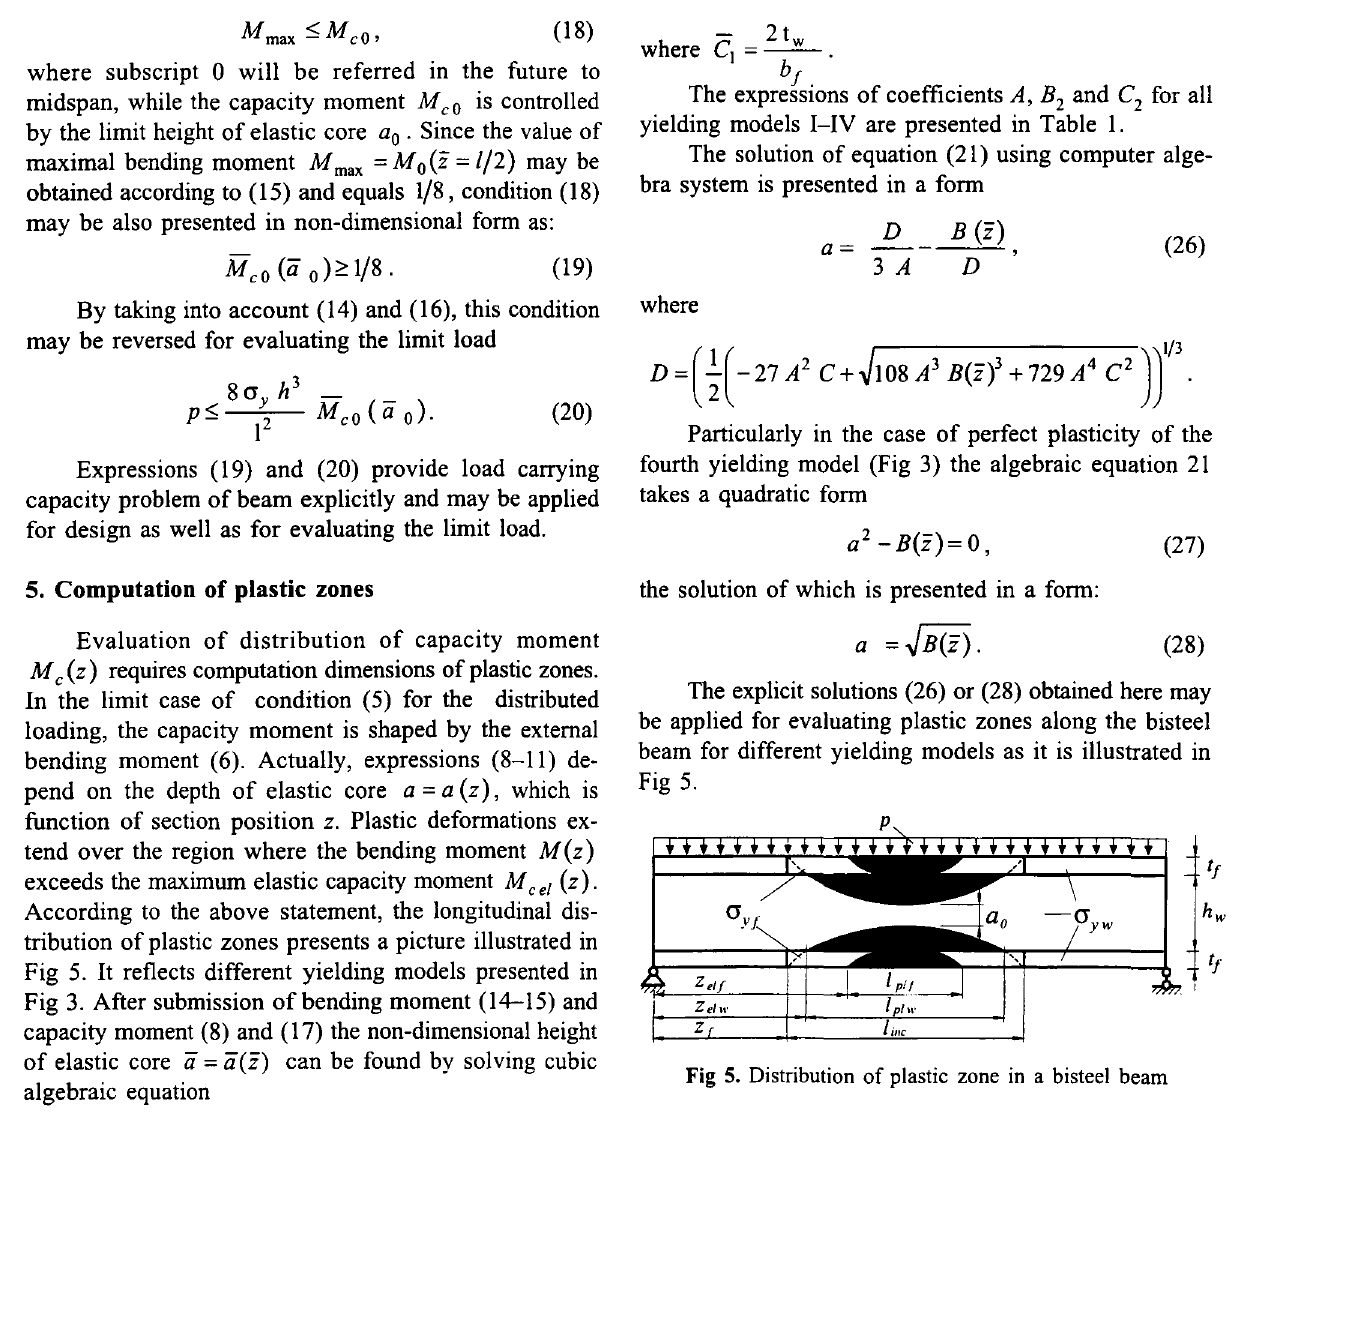
Fig 5. Distribution of plastic zone in a bisteel